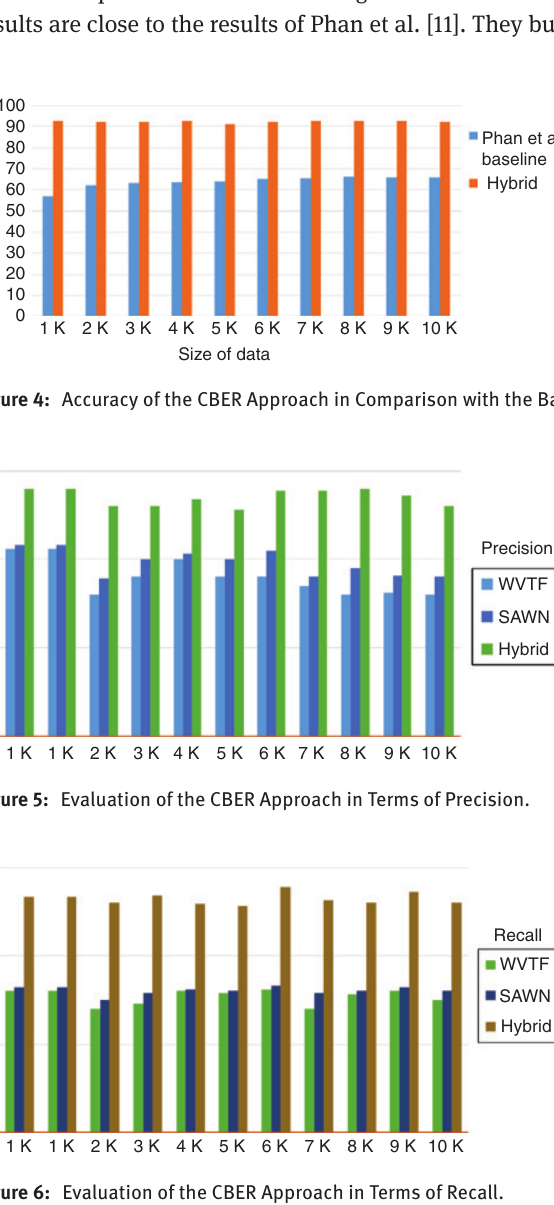
Figure 6: Evaluation of the CBER Approach in Terms of Recall.